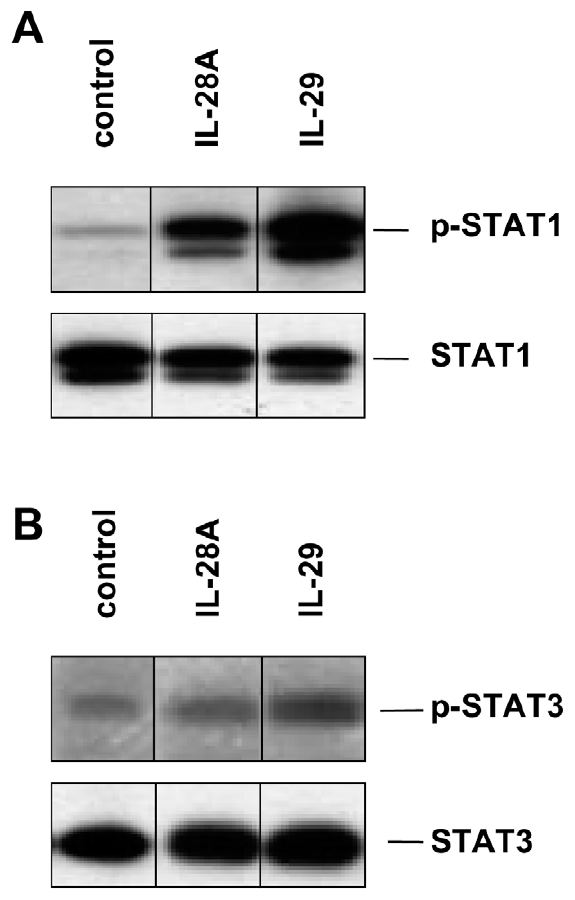
Figure 1. The IFN- l receptor complex consisting of IL-10R2 and IFN l -R1 is expressed in hepatic cell lines. (A) Expression of IL-10R2 and IFN l -R1 in various hepatic cell lines, primary hepatocytes from two different donors and primary leukocytes were analyzed by RT-PCR analysis of mRNA derived from cells as indicated. The prostate cancer cell line LnCaP was used as a negative control for IFN l -R1 expression. (B) Quantitative PCR analysis reveals a much lower expression of IFN l -R1 mRNA in leukocytes from four different donors in comparison to liver cells. PBMC express twice as much IFN- l R1 than granulocytes. Expression data are normalized to Huh-7 cells. (C) IL-10R2 was expressed at higher levels in leukocytes in comparison to hepatic cells. Data are normalized to the expression in Huh-7